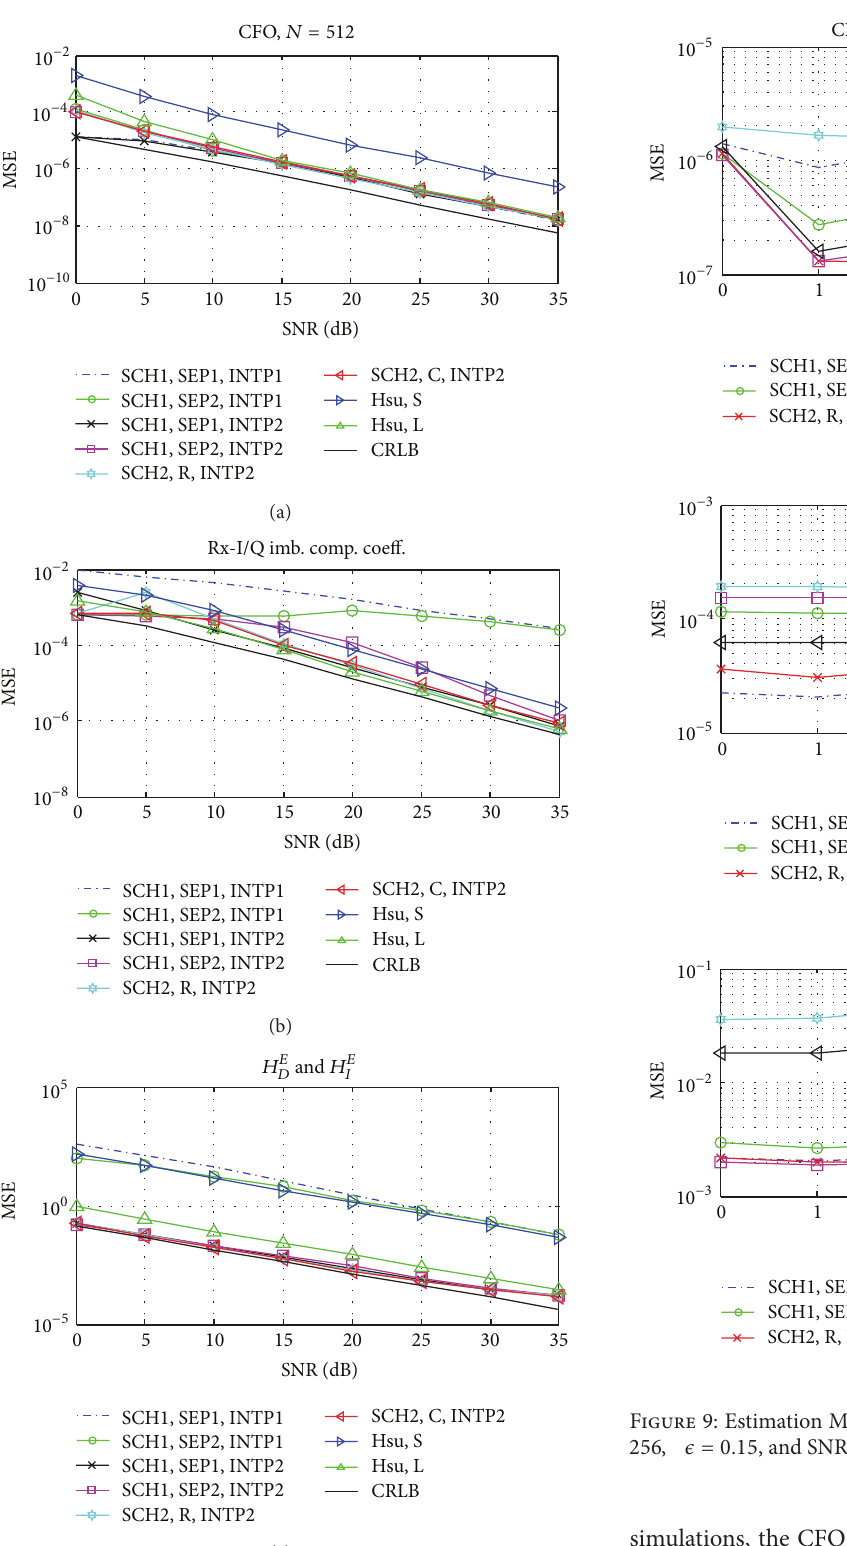
simulations, the CFO value was evenly distributed between 0 and 0.45𝑁/𝑁 𝑃 . To avoid influence of residual CFO, only 8 OFDM symbols are transmitted within each signal frame. (This is just a simulation example to investigate the performance without the need of phase tracking.) The used modulation scheme was 16-QAM. Moreover,